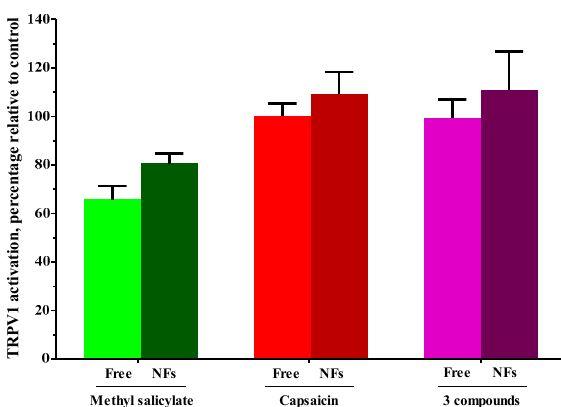
Figure 4. Effect of the encapsulation on the ability of the experimental compounds to activate TRPV1. Fluorescence time-course assays were performed on cells stably expressing TRPV1 and treated with the agonist compounds employed either alone or in combination, and also including salicylic acid (three compounds). These samples included compound-containing nanofibers (NFs) and non-encapsulated compounds (Free). The level of activation is calculated as the percentage relative to the highest value from the time-course in cells treated with 10 μ M of capsaicin and the lowest value from RR treatment. Statistical analysis comprised two-way ANOVA corrected with Tukey’s test for multiple comparisons (Free vs. NFs) and no significant differences were found between the experimental and control samples.